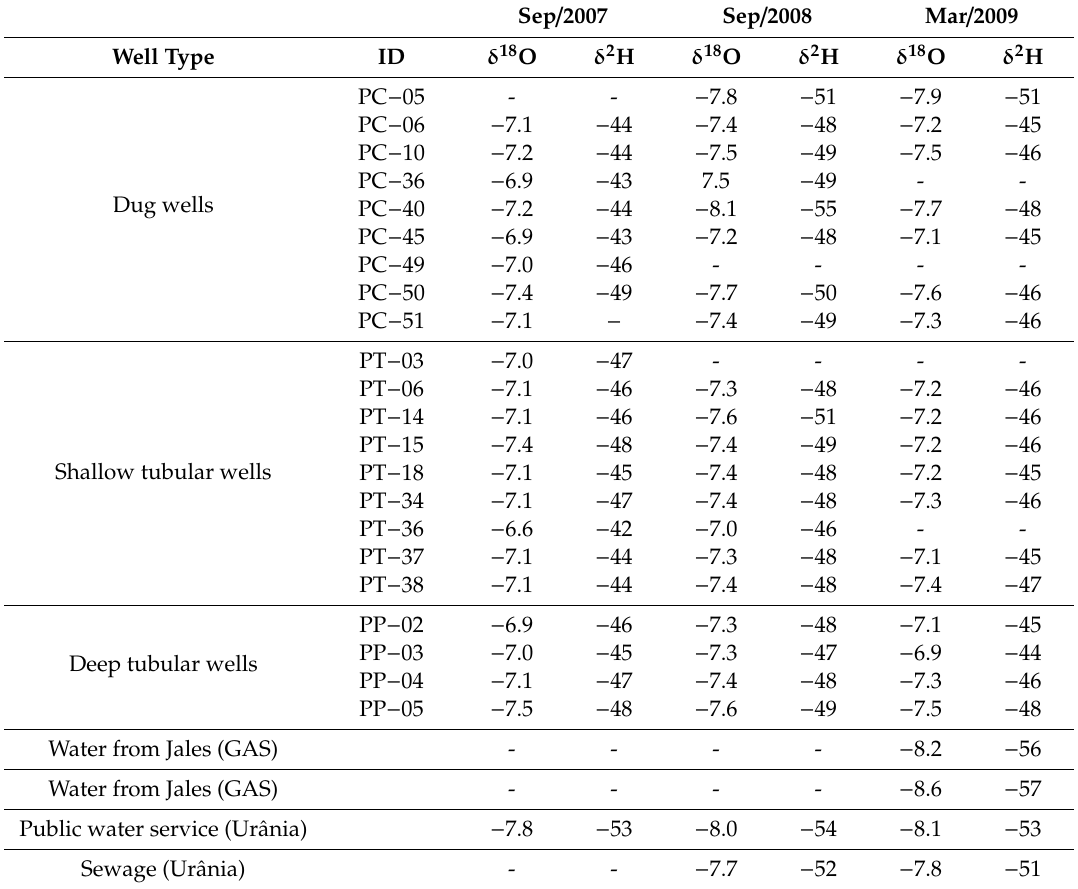
Table 2. Stable isotopic results for groundwater and sewage (% (cid:24)